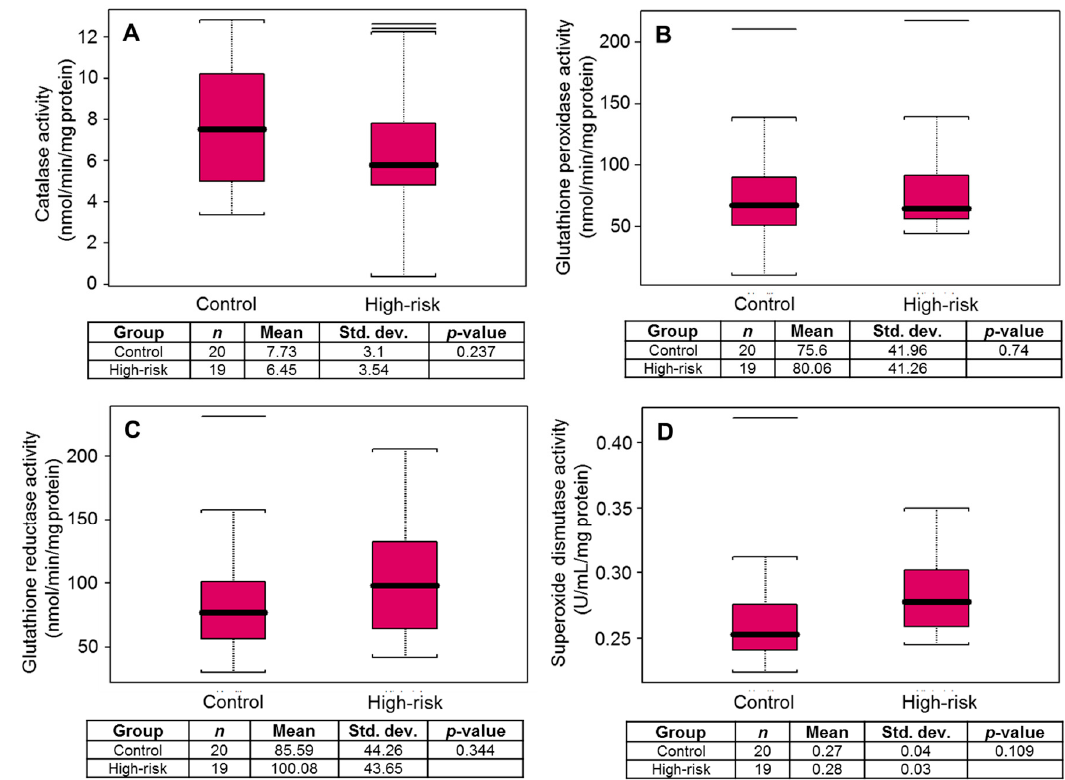
Figure 3. Box plot for ( A ) catalase, ( B ) glutathione peroxidase, ( C ) glutathione reductase, and ( D ) superoxide dismutase activity in healthy controls and high-risk subjects for prostate cancer. Black bar = median, red box = 25th to 75th percentiles, Bars = entire range. The horizontal lines beyond the bars are outliers or whiskers are drawn individually.